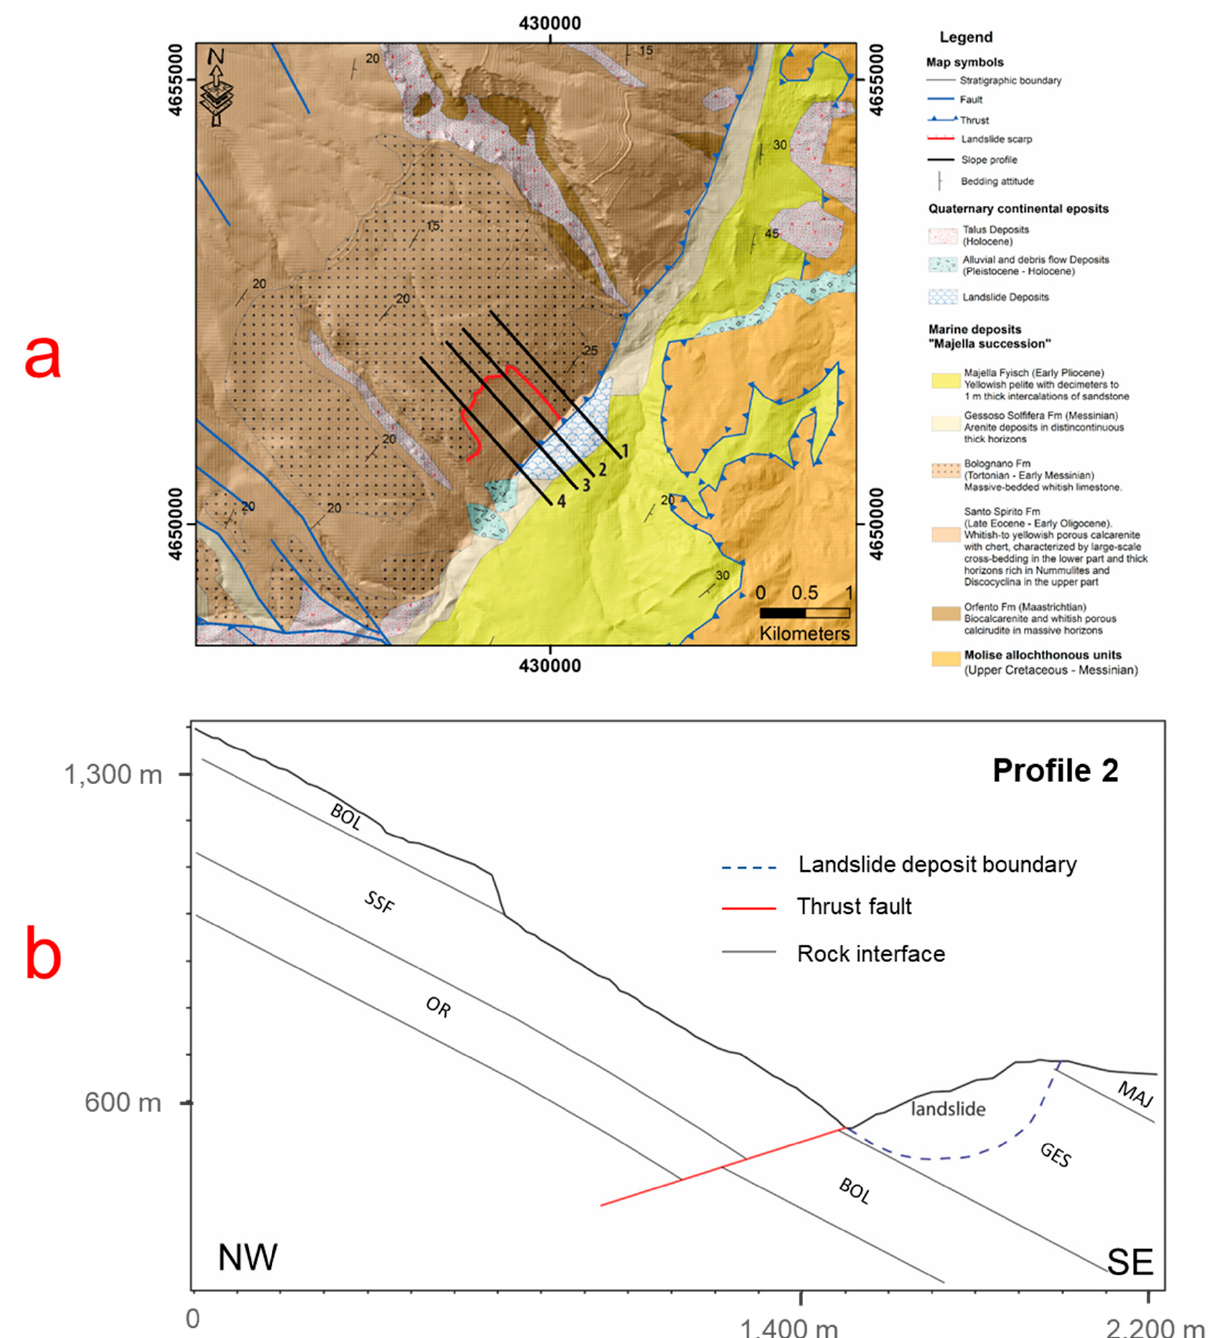
Figure 2. ( a ) the geological map of the study area after Vezzani and Ghisetti [41] and Miccadei et al., [42], highlighting the location of 4 profiles (profiles 1–4) and ( b ) 2D section (along Profile 2) of the analysed slope, showing the lithology, distribution of discontinuities and landslide deposits. Regarding the structural geology, the slope is characterized by the convex relief of the bedding as the presence of an anticline, whose bedding inclination undergoes a gradual increase from sub-horizontal angles (10 ◦ –20 ◦ ) on the crest of the slope to tilted angles (25 ◦ –30 ◦ ) in the medium-low part of the slope (Figure 2). There are two thrust faults in the analysed slope (Figure 2a). One is dipping towards SE and causing the Molise unit to overlie the Majella unit (as aforementioned), and the second dipping towards NW and resulting in uplift of hanging wall of Majella